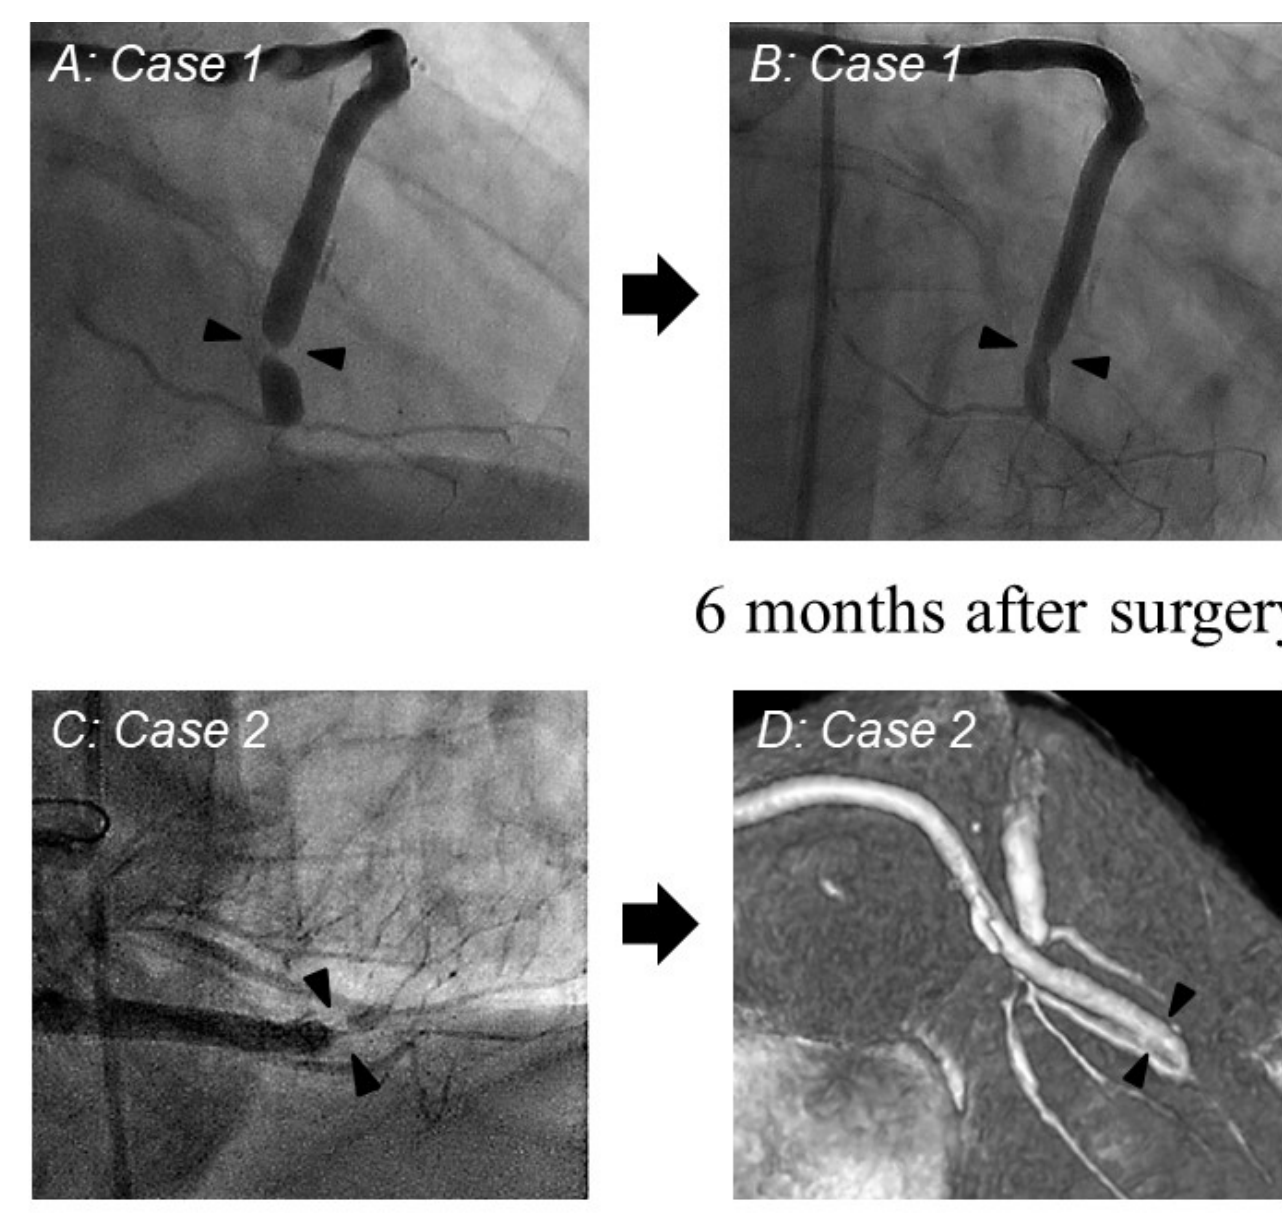
Fig. 1 - Contrast angiography one week after surgery demonstrating graft twisting (black arrows: A and C) in “no-touch” saphenous vein grafts. At six months after surgery, spontaneous resolution of graft twisting was observed in contrast angiography and enhanced computed tomography angiogram (black arrows: B and